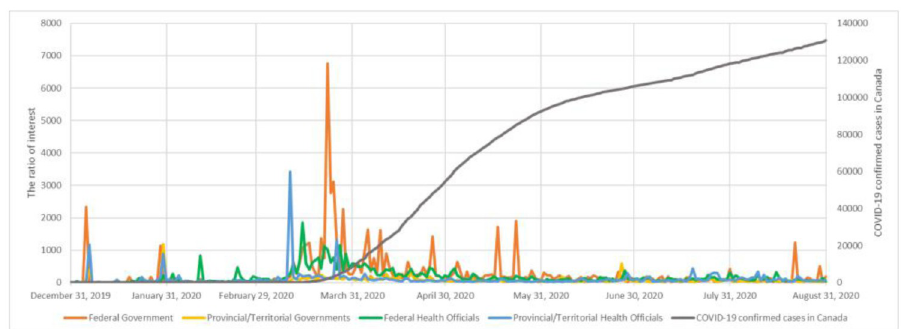
Fig 5. The ratio of interest [the ratio of the number of interactions to the number of tweets] towards the COVID- related tweets by Canadian officials x number of COVID-19 confirmed cases in Canada from December 31,